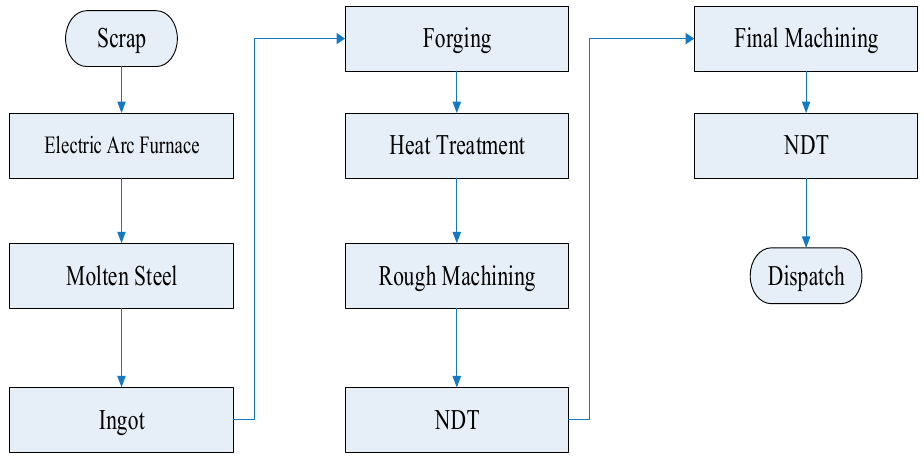
Figure 3. Flow chart depicting critical processes in the manufacturing of the sugar mill roller shaft.